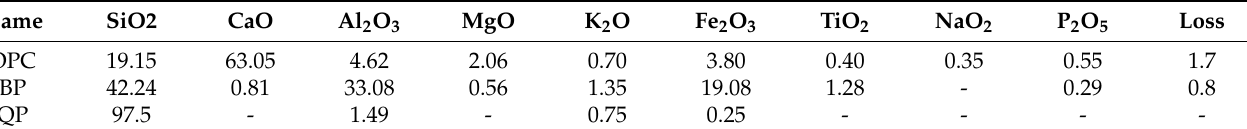
Table 1. Chemical compositions of materials (%). Table 2. Mix proportions of paste.